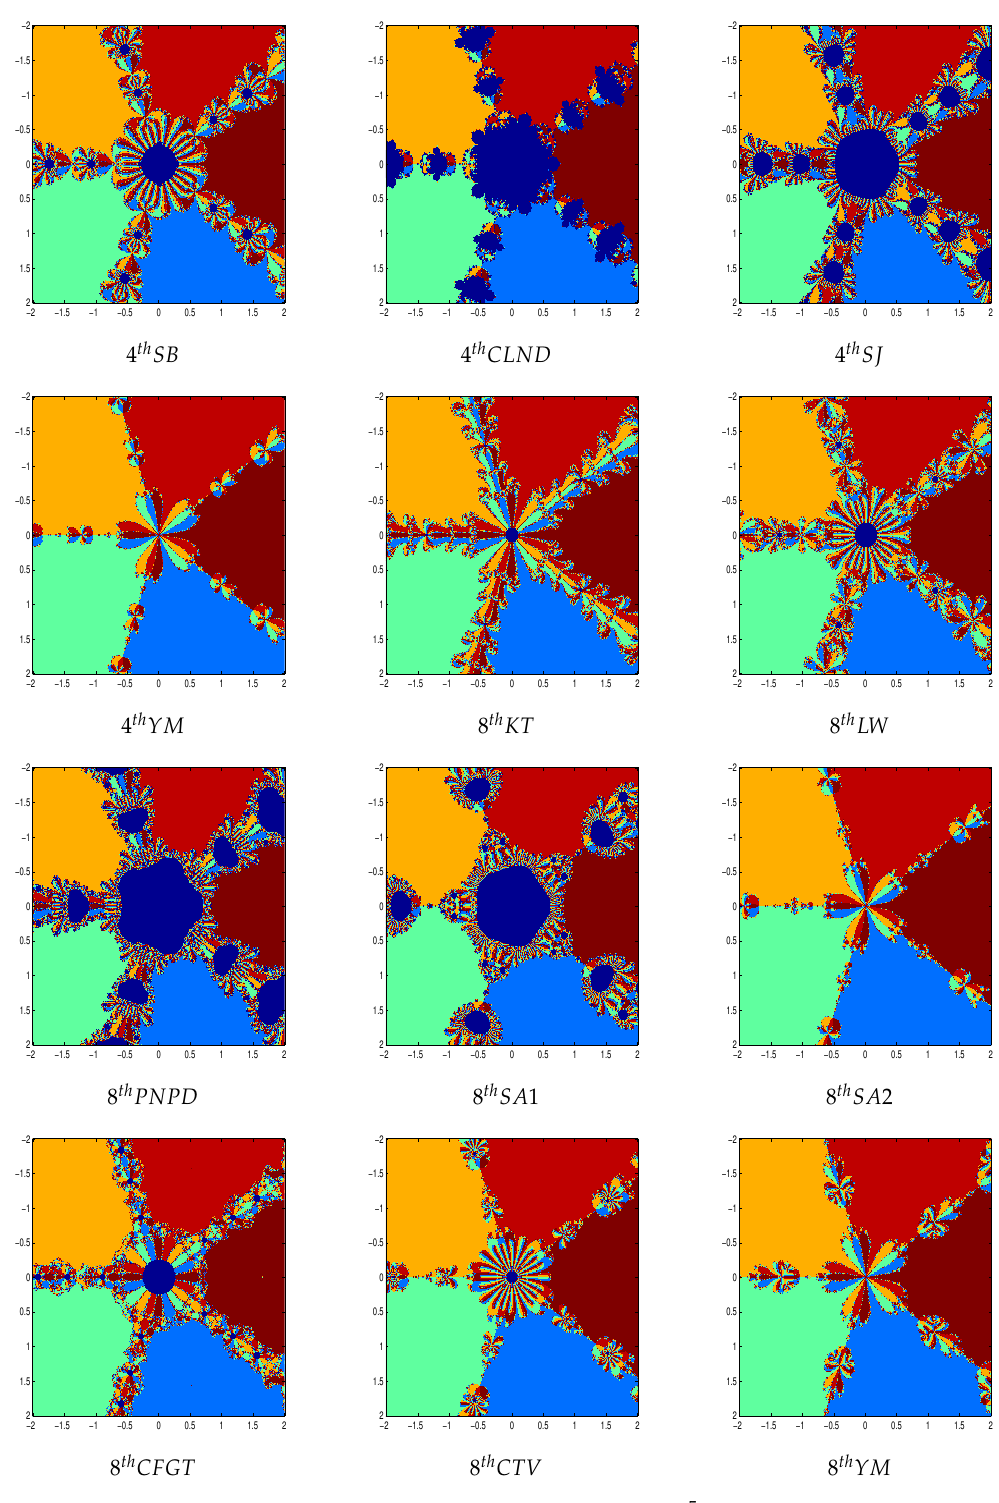
Figure 5. Basins of attraction for p 3 ( z ) = z 5 −